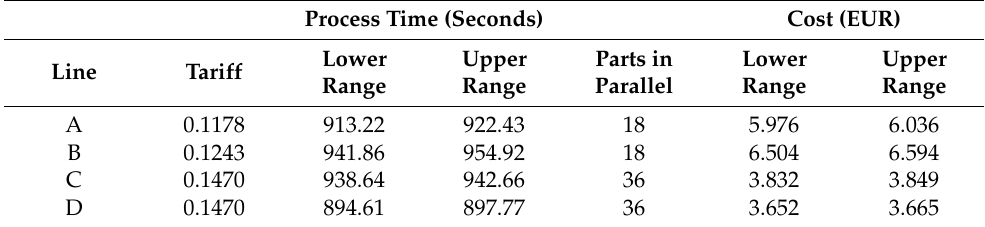
Table 10. Range of product cost considering the confidence interval for the mean, per